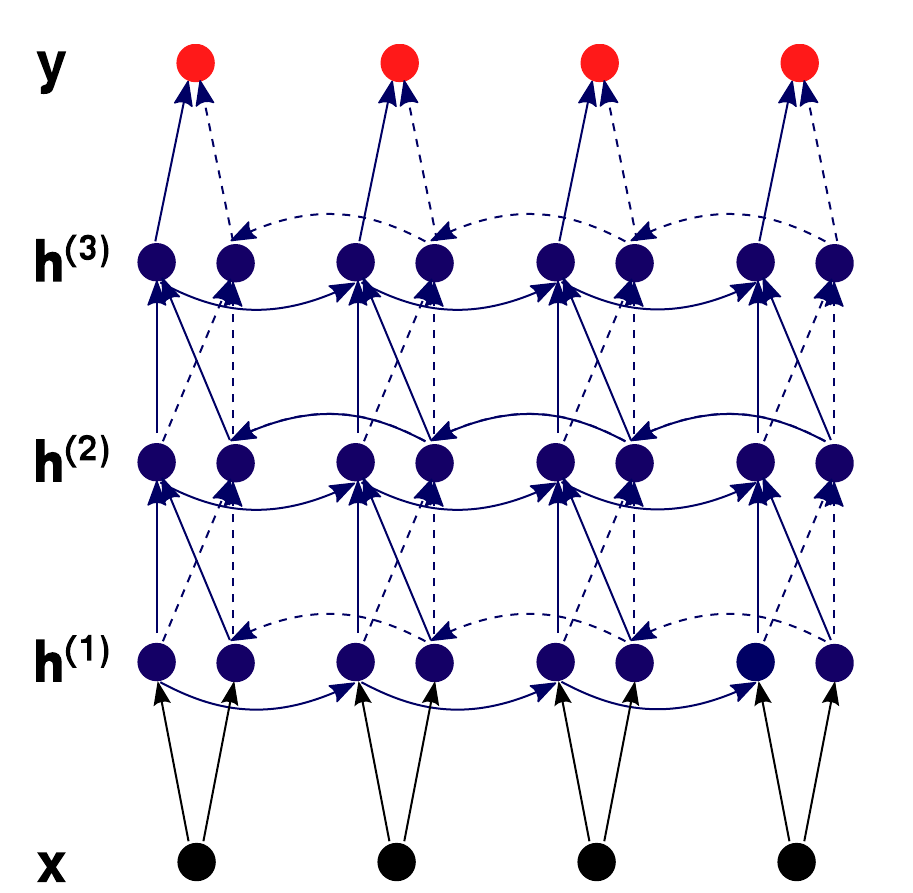
Fig 2. Schematics of a bidirectional recurrentneural